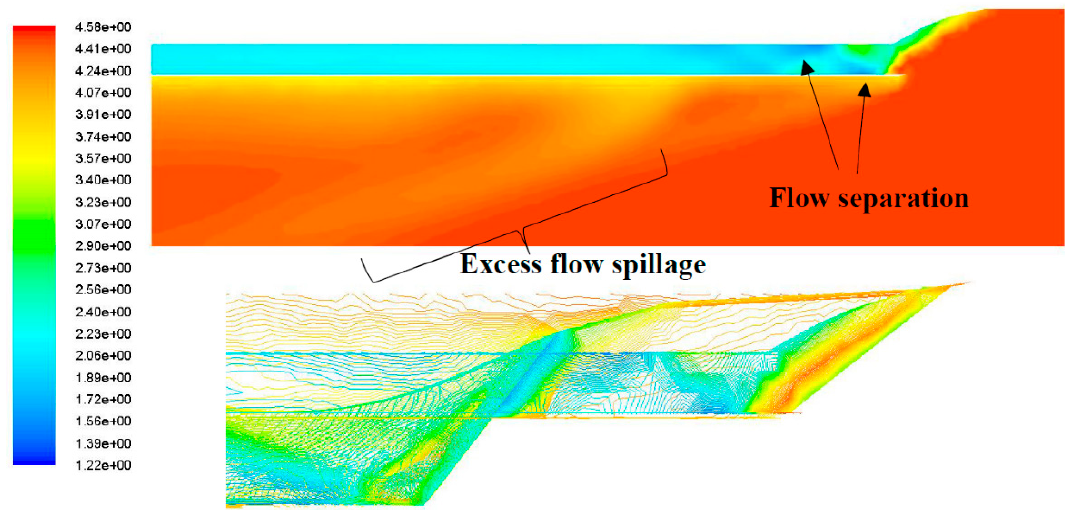
Figure 38. Mach contour of same orientation ramjet and scramjet inlets at Mach 4.5.